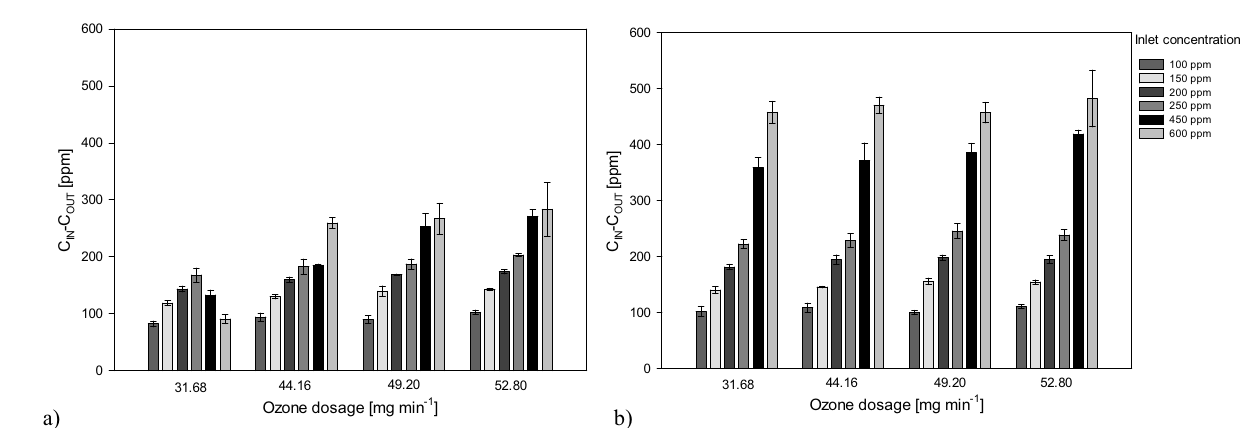
Figure 3. Influence of ozone dosage on the toluene abatement under different inlet concentrations applying the UV/O 3 system ( a ) and the UV/O 3 + S system ( b